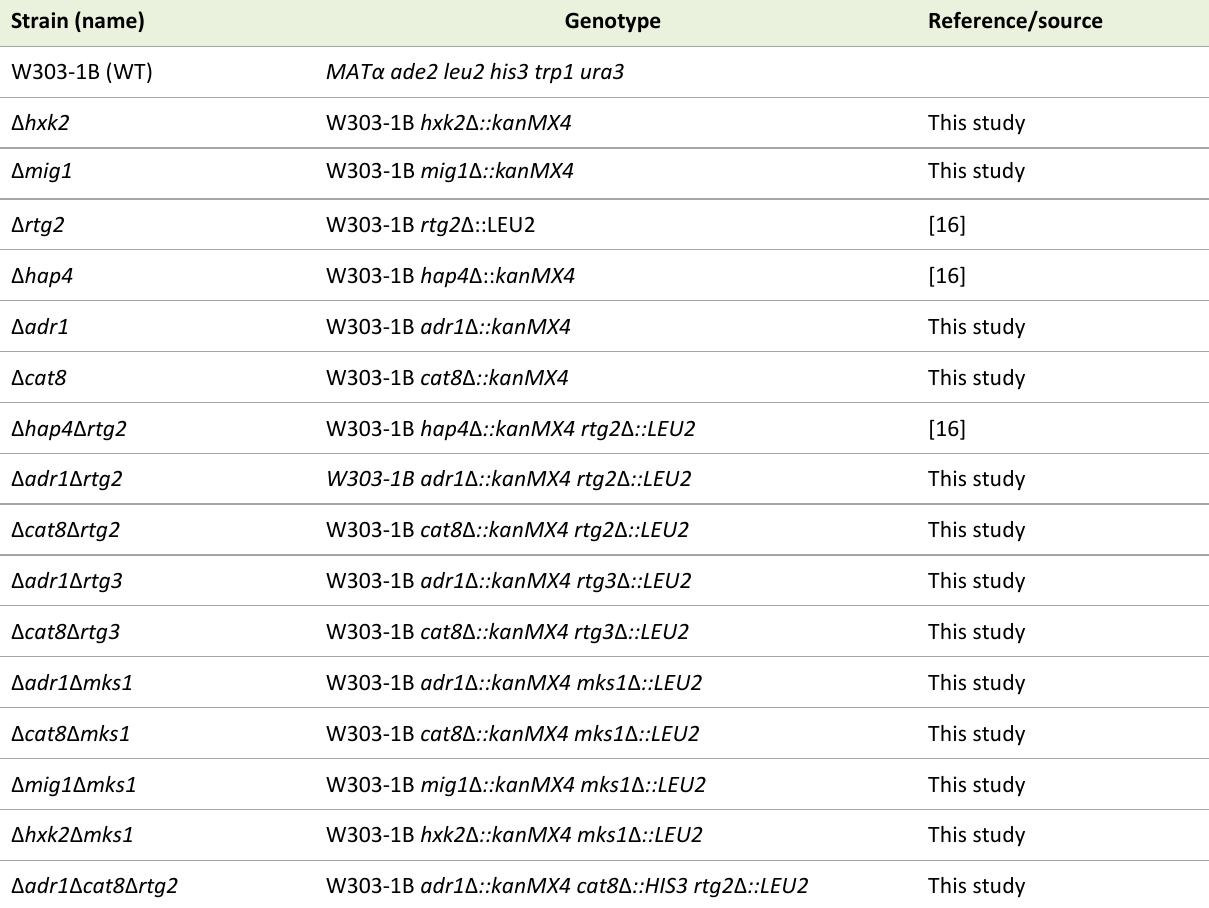
TABLE 1. Strains of Saccharomyces cerevisiae used in this